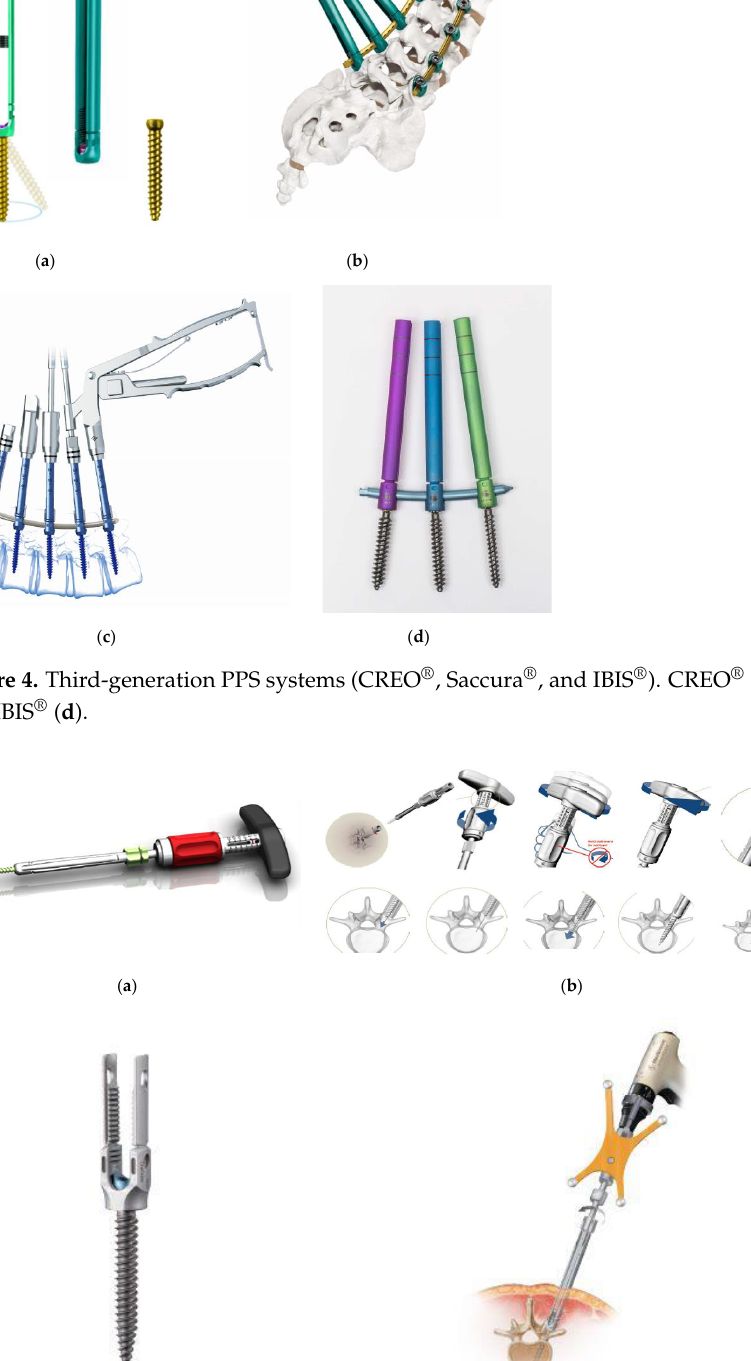
Figure 5. Fourth-generation PPS systems (VIPER PRIME ® and Voyager ATMAS ® ). VIPER PRIME ® ( a , b ) and Voyager ATMAS ® ( c , d ).